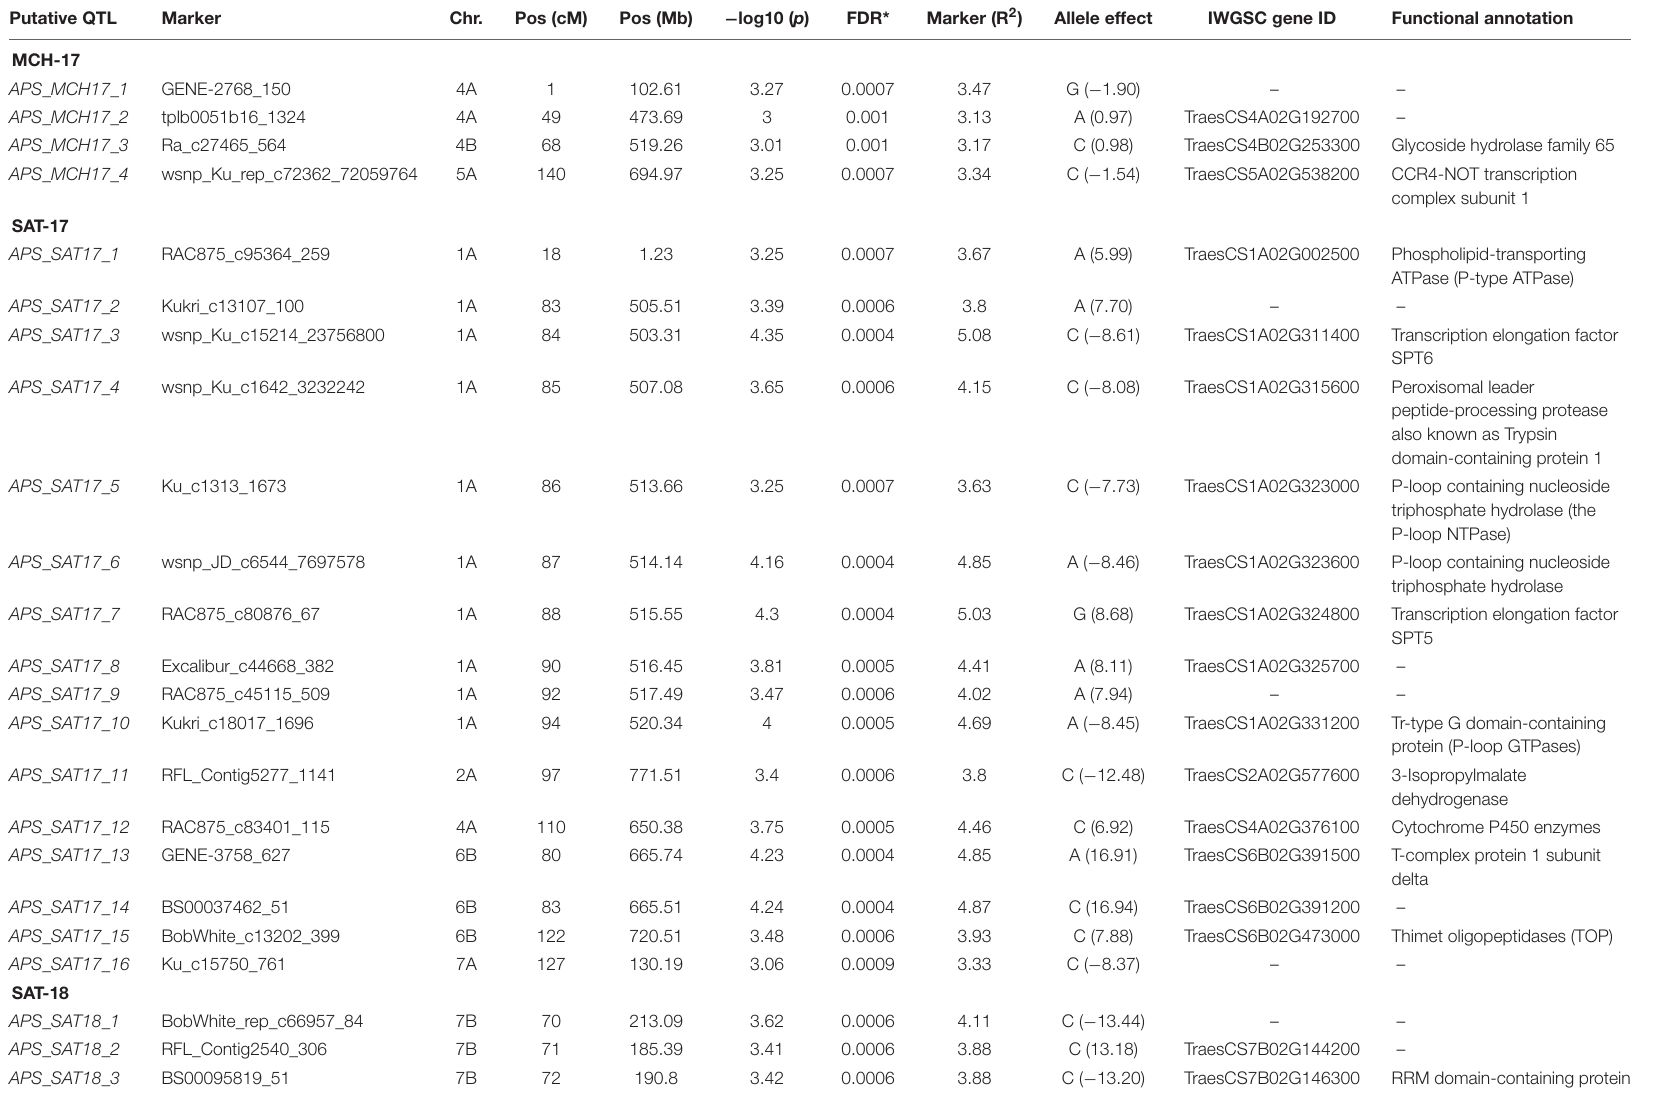
TABLE 4 | GWAM for adult plant resistance based on disease severity and AUDPC at Sidi Allal Tazi during 2017 (SAT-17), 2018 (SAT-18), and at Marchouch during 2017 (MCH-17) in Morocco. Putative